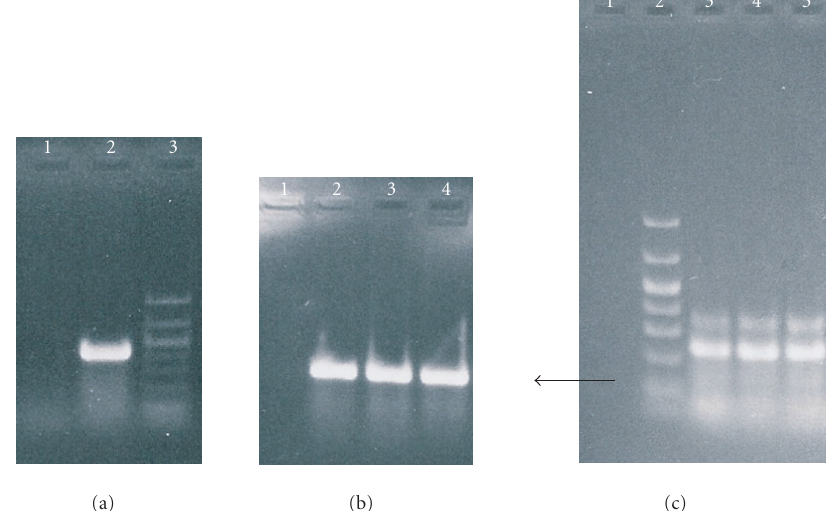
Figure 7. Agarose gel electrophoresis of RT-PCR products of mRNA isolated from ES cells, EBs, and osteogenic cells. In (a), lanes 1 and 2 show the RT-PCR product of oct 4, and lane 3 shows molecular weight markers (1000, 700, 500, 400, 300, 200, 100, and 50 bp). In (b), lanes 1 and 2 represent the RT-PCR product of OP from ES cells and EBs, respectively. Lanes 3 and 4 represent the RT-PCR product of OP from osteogenic cells grown in the tissue culture plate and 3D sca ff old, respectively. The arrow indicates the molecular size of 400 bp. In (c), lanes 1, 3, 4, and 5 represent the RT-PCR product of OC from the cells as described in (b) above. Lane 2 represents the molecular weight markers as described in